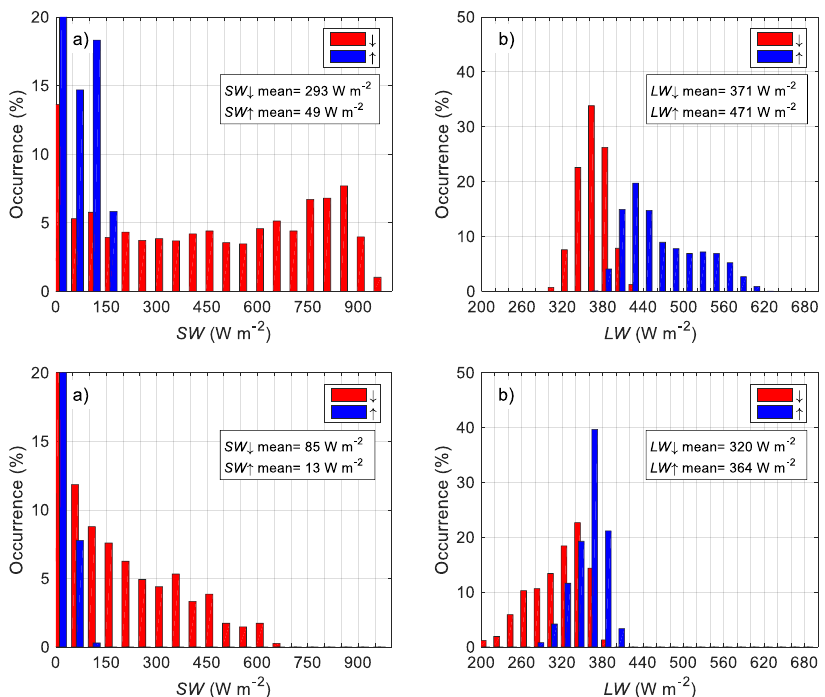
Figure 6. Histograms of ( a ) visible (short-wave) SW radiation and ( b ) infrared (long-wave) LW radiation. Upper panels: Summer months (June–August); lower panels: Winter months (December–February). Hourly averages were used to calculate the